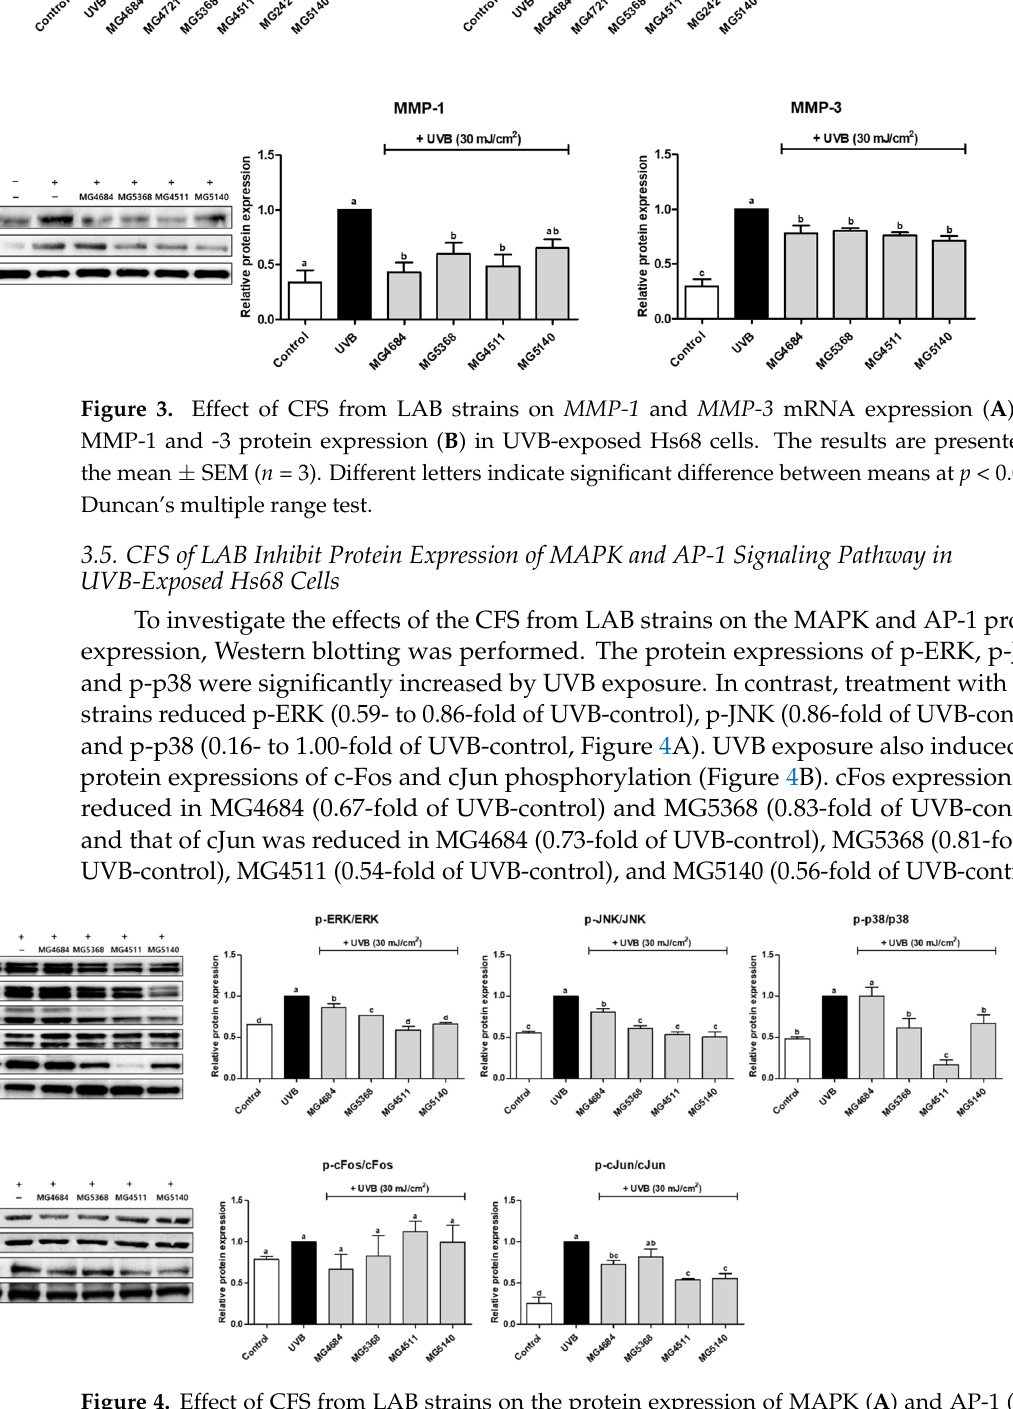
Figure 4. Effect of CFS from LAB strains on the protein expression of MAPK ( A ) and AP-1 ( B ) in UVB-exposed Hs68 cells. The results are presented as the mean ± SEM ( n = 3). Different letters indicate significant difference between means at p < 0.05 by Duncan’s multiple range